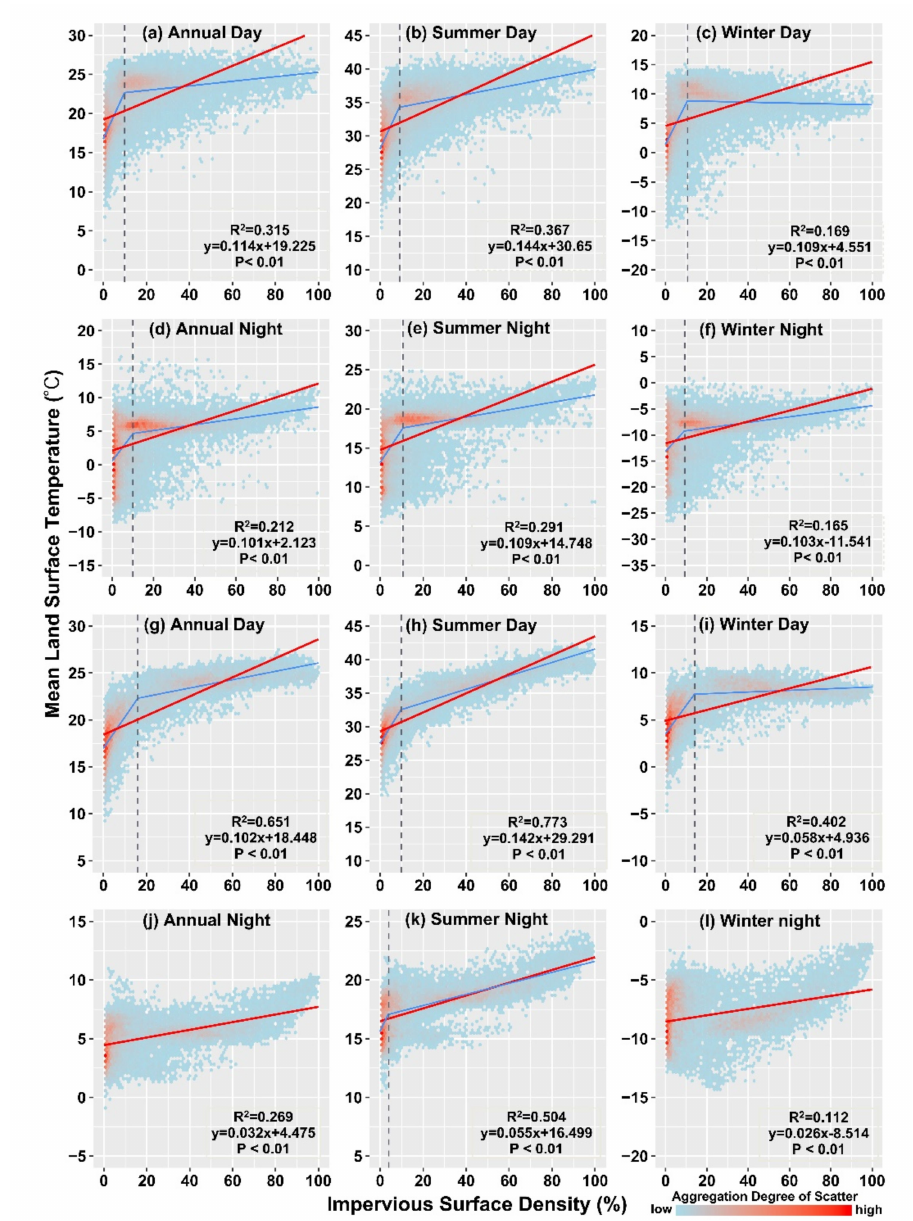
Figure 8. Relations between the density of the impervious surface area and the LST across the BTH. ( a – f) : Relations between the density of the impervious surface area and respectively the annual daytime LST, summer daytime LST, winter daytime LST, annual nighttime LST, summer nighttime LST, and winter nighttime LST across the BTH; ( g – l ): relations between the density of the impervious surface area and respectively the annual daytime LST, summer daytime LST, winter daytime LST, annual nighttime LST, summer nighttime LST, and winter nighttime LST across the Beijing city. Red line shows linear trends for the entire series; blue line shows piecewise fitting results. The dashed line shows the time when change point